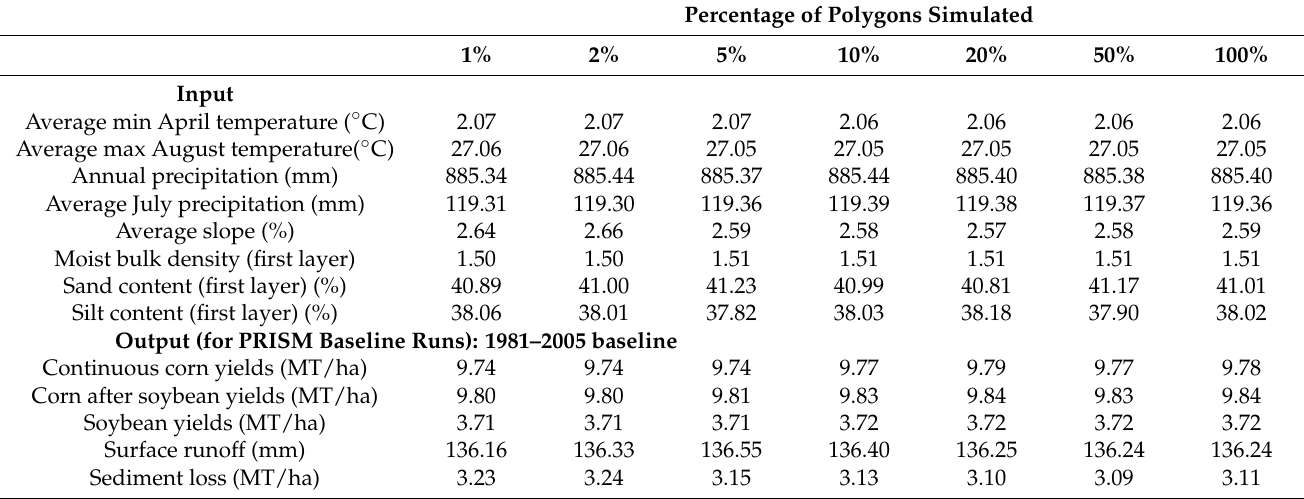
Table 7. Selected input and output indicators by percentage of polygons